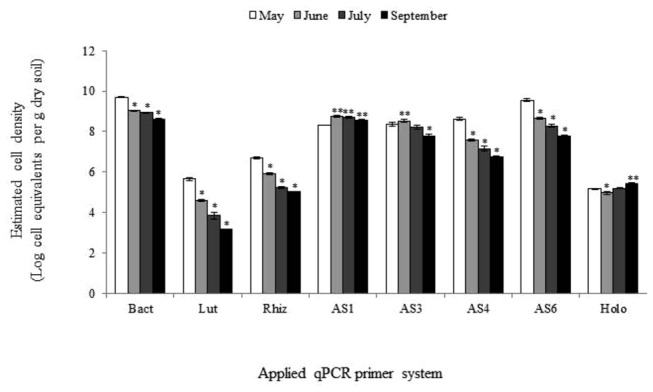
Dynamics of total bacteria, Luteolibacter and Candidatus genus Rhizospheria and of subdivisions 1, 3, 4, 6 acidobacteria and holophaga in fallow field soil over time measured by qPCR.Bact, total bacteria; Lut, Luteolibacter; Rhiz, Candidatus genus Rhizospheria; AS1, AS3, AS4, AS6, respectively, subdivision 1, 3, 4, 6 acidobacteria; Holo, holophaga. Bars on top of columns represent standard errors of means; *, significant decrease and **, significant increase in comparison with respective samples drawn in May.